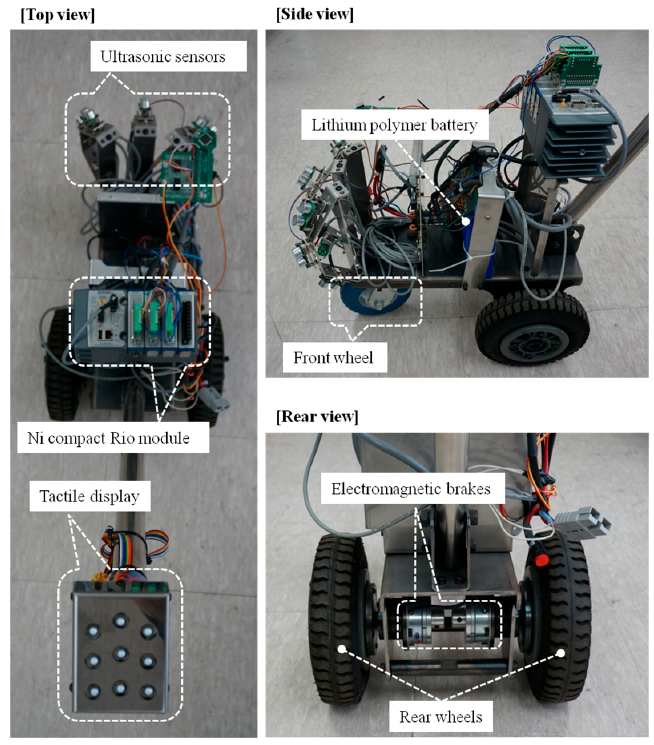
Figure 2. The developed Electronic Travel Aid (ETA) system.